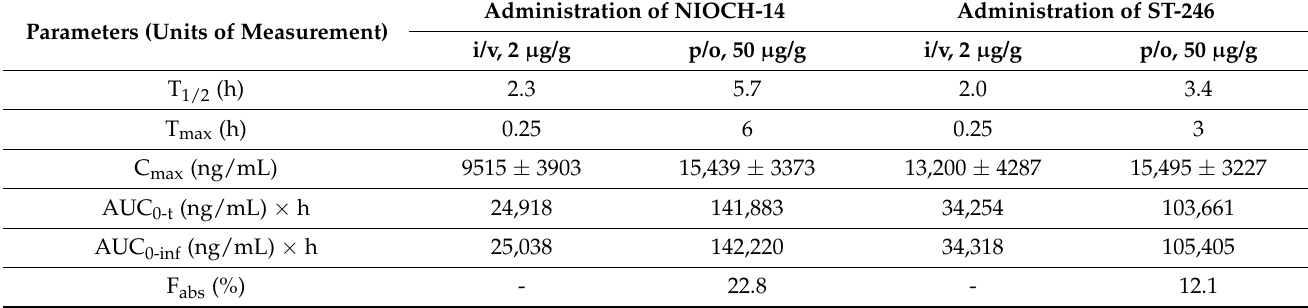
Figure 3. Changes in concentration of the active metabolite ST-246 in mouse serum as a function of time after single-dose intravenous (i/v) administration of the substance NIOCH-14 (2 µg/g body weight) ( A ) and single-dose oral (p/o) administration of the substance NIOCH-14 (50 µg/g body weight) ( B ). Changes in concentration of the reference drug ST-246 in mouse serum as a function of time after its single-dose i/v injection (2 µg/g body weight) ( C ) and single-dose p/o administration (50 µg/g body weight) ( D ). The values at each point are presented as M ± SD. * — the difference from the threshold level (20 ng/mL) according to the Student’s t -test at p ≤ 0.05. Figure 3A,B shows that the maximum concentration of ST-246 in mouse serum was observed 15 min after intravenous and 6 h after oral administration of the substance NI- OCH-14 (9.52 and 15.44 µg/mL, respectively). After intravenous administration of the ref- erence drug ST-246, its maximum concentration in serum (13.20 µg/mL) was also ob- served after 15 min, whereas after oral administration of the reference drug ST-246, its maximum concentration (15.50 µg/mL) was reached after 3 h (Figure 3C,D). Table 5 lists the calculated final pharmacokinetic parameters (T 1/2 , T max , C max , AUC 0-t , AUC 0-inf , and F abs ) of the active metabolite ST-246 in mouse serum after single-dose intra- venous and oral administration of the substance NIOCH-14 at doses of 2 and 50 µg/g body weight, respectively, as well as the reference drug ST-246 at the same doses and routes of administration. It was shown that the F abs of the substance NIOCH-14 was 22.8% upon its oral administration at a dose of 2 µg/g body weight (Table 5). Furthermore, the pharma- cokinetic parameters of the reference drug ST-246 in mouse serum were used to calculate its F abs , which was 12.1% upon oral administration at a dose of 50 µg/g body weight with respect to intravenous administration at a dose of 2 µg/g body weight (Table 5). Hence, the absolute bioavailability of the substance NIOCH-14 was found to be not lower than that of the reference drug ST-246. Table 5. Pharmacokinetic parameters (in the serum) of the substance NIOCH-14 and the reference drug ST-246 administered as a single dose (2 µg/g body weight) intravenously (i/v) and oral (p/o) to mice at a dose of 50 µg/g body weight.